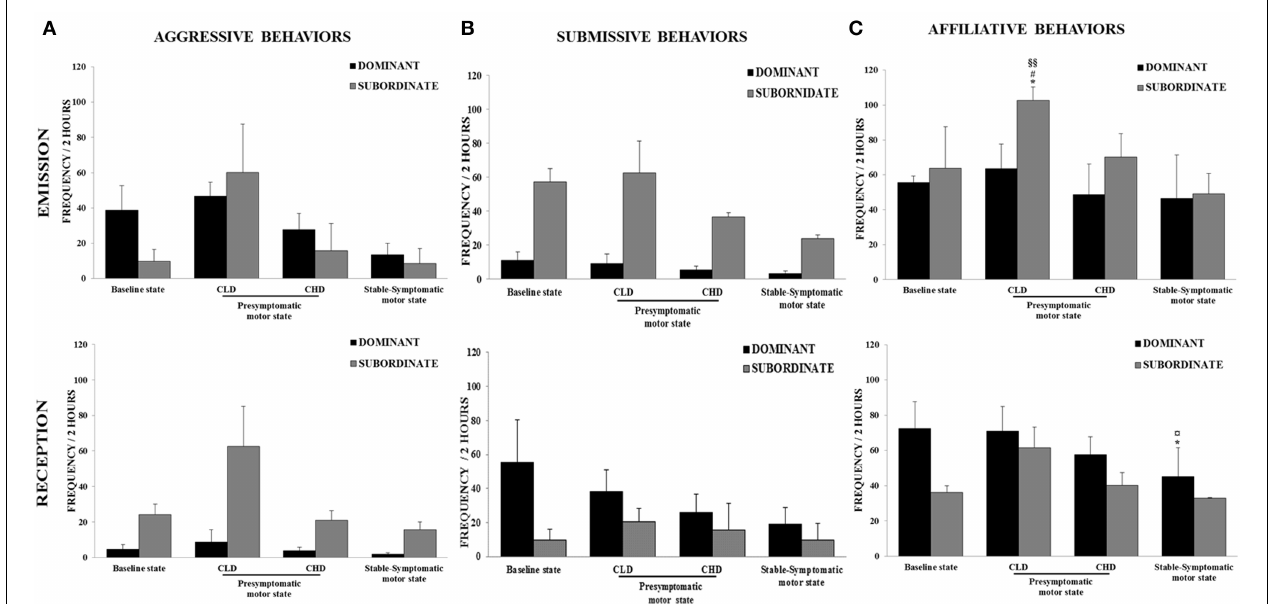
FIGURE 5 | Evolution of social behaviors from baseline to presymptomatic and symptomatic motor states within the two social subgroups ( n = 3 in each subgroup). (A) Aggressive behaviors were recorded in terms of emission and reception using the focal animal sampling method for each monkey. (B) Submissive behaviors were recorded in terms of emission and reception using the focal animal sampling method for each monkey. (C) Affiliative behaviors were recorded in terms of emission and reception using the focal animal sampling method for each monkey. Values